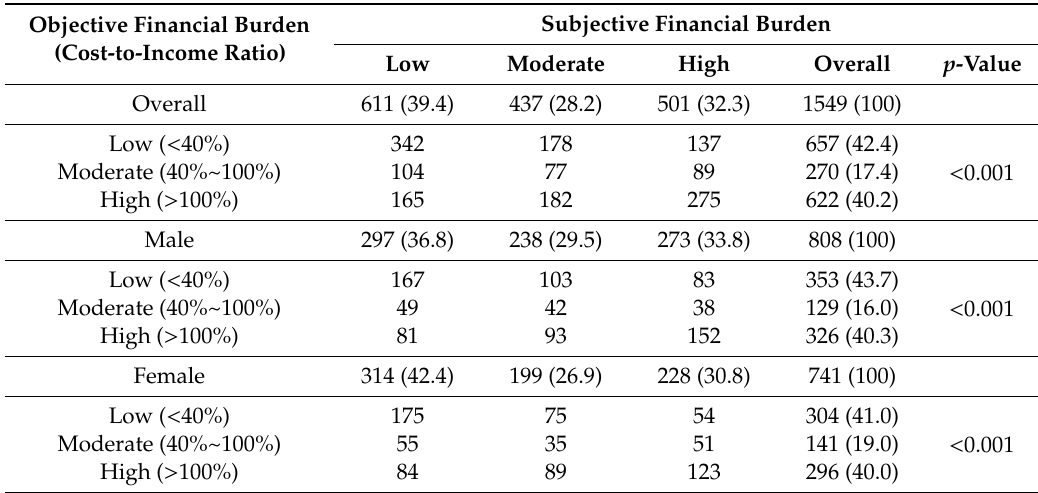
Table 2. Comparison between patients reported subjective and objective financial